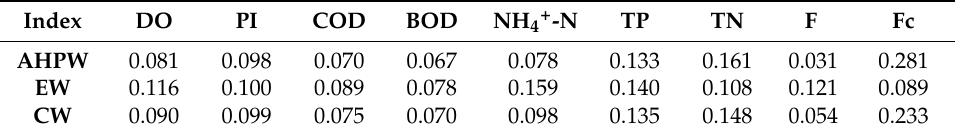
Table 3. Index weights obtained by the three methods.